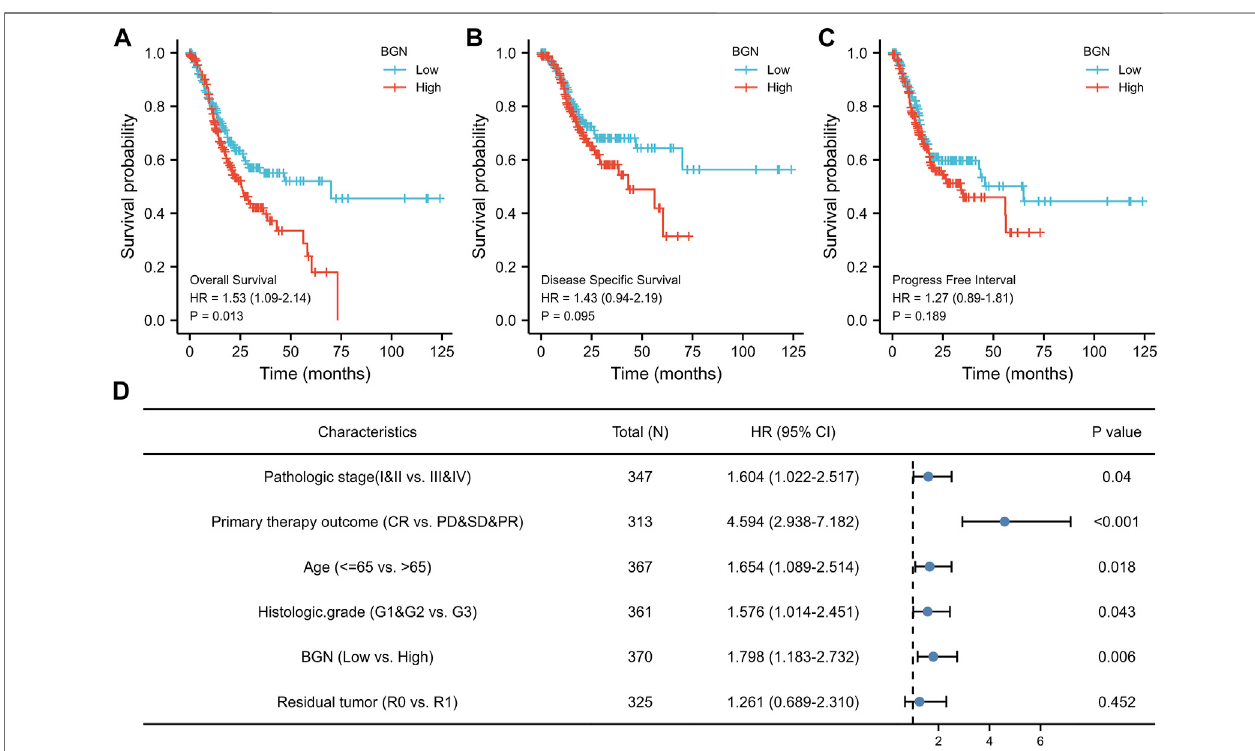
FIGURE 4 | The correlation between BGN expression and immune in fi ltration. (A) Correlation between the relative abundances of immune cells and BGN expression level. The size of dots is positively related to the absolute value of Spearman ’ s R. (B-D) The difference of immune cells (Macrophages, NK cells, and Th17 cells) between the high and low expression groups based on the median value of BGN expression. (E – G) The correlation of immune cells (Macrophages, NK cells, and Th17 cells) between the high and low expression groups based on median value of BGN expression.